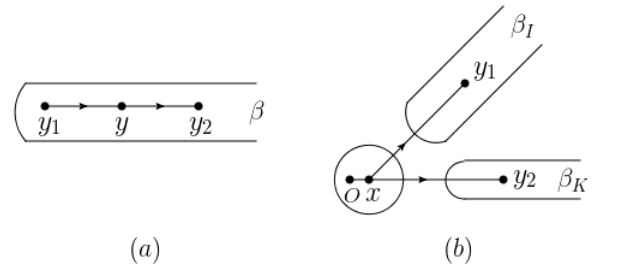
Figure 44. Examples of the formation of pinches in position